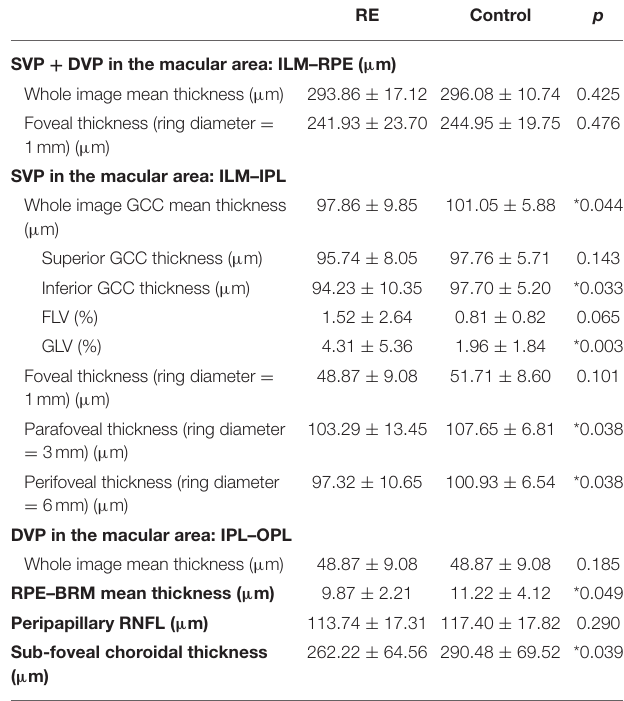
RE,radiationencephalopathy;SVP,superficialvascularplexus;DVP,deepvascularplexus; ILM,internallimitingmembrane;RPE,retinalpigmentepithelium;IPL,innerplexiformlayer; GCC: ganglion cell complex, includes retinal nerve fiber layer, ganglion cell layer, and inner plexiform layer; FLV, focal loss volume, the sum of fractional deviation in the region where there is significant focal loss (pattern deviation more than 1.65 standard deviations below the normal average); GLV, global loss volume, the sum of fractional deviation in areas where fractional deviation is negative; OPL, outer plexiform layer; BRM, Bruch’s membrane; RNFL, retinal nerve fiber layer. RNFL thickness, GCC thickness, FLV, and GLV were measurements in retinal ganglion cells assessment. * p <